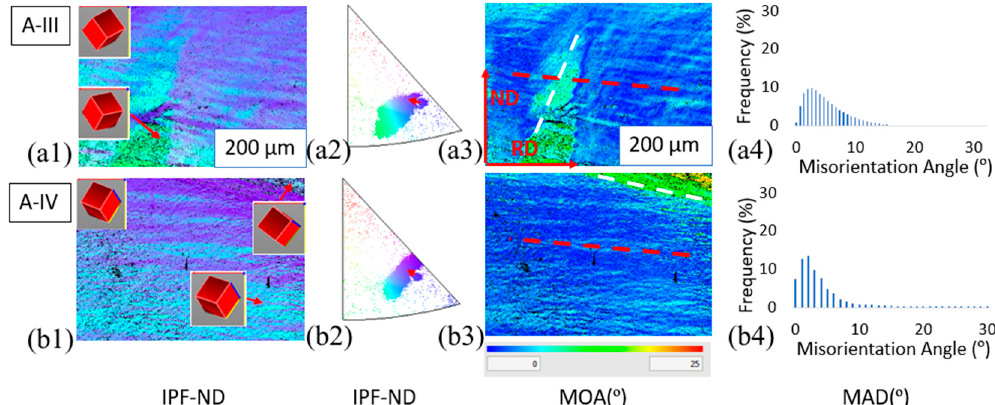
Figure 10. (a1 – a4 ) and ( b1 – b4 ) are figures for A-III and A-IV. ( a1 ) and ( b1 ) are the EBSD IPF-ND maps for crystals after compression. ( a2 ) and ( b2 ) are the IPF-ND of the undeformed and deformed crystals plotting together, with the arrow indicates the rotation around the loading direction. ( a3 ) and ( b3 ) are the MOA maps of deformed crystals. Red dashed lines represent the alignment of the most apparent DBs set generated in the first loading. White dash lines approximate the direction of dislocation created in the second loading. ( a4 ) and ( b4 ) are the MAD for crystals after deformation.